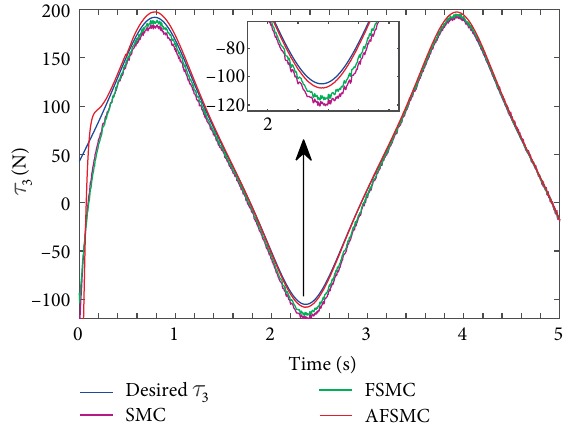
Figure 25: The tracking response of the third driving force